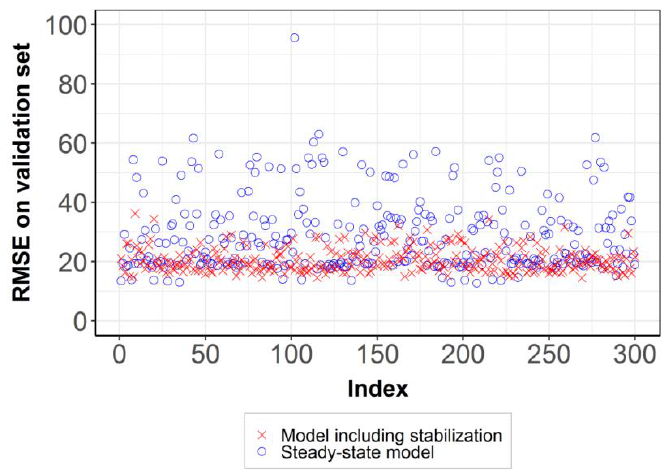
Figure 9. The indicator root mean square error (RMSE) on validation dataset (300 times of